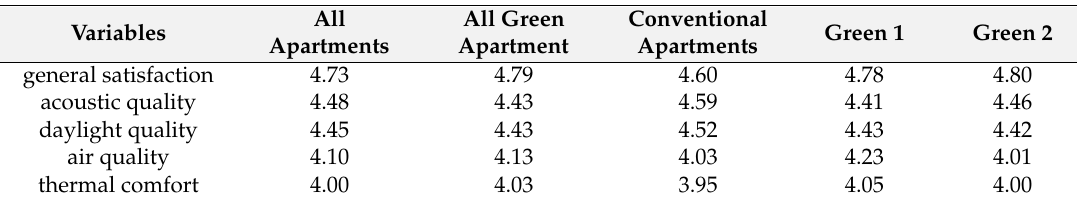
Mean values for general satisfaction among occupants of conventional and green building apartments.